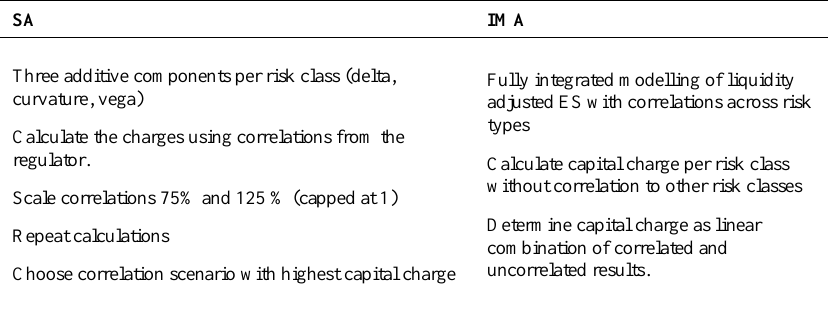
Table 7. Comparison of the standardised approach and the internal model